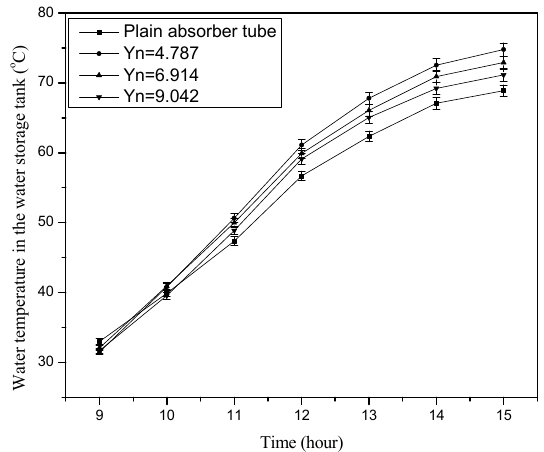
Figure 8. Variation of water temperature in the water storage tank with time and nail twist pitch ratio.